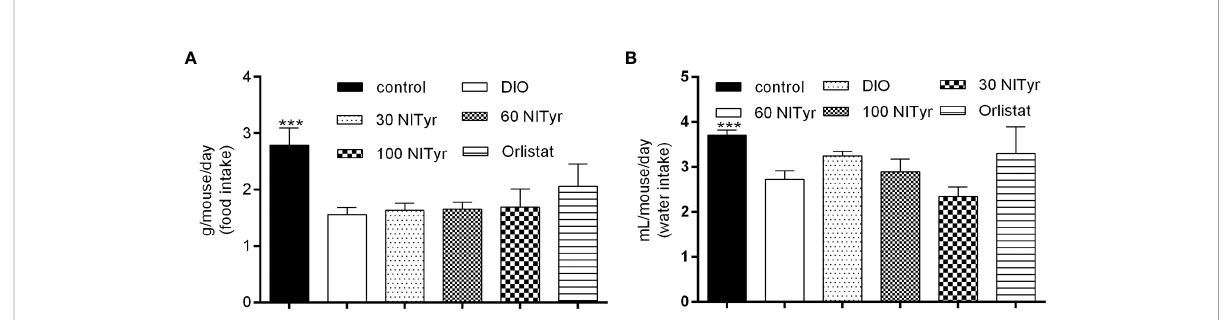
FIGURE 3 (A) Average food intake during 4-week drug intervention. (B) Average water intake during 4-week drug intervention. Control or DIO was treated with Poloxamer 188 aqueous solution. 30 NITyr, 60 NITyr, 100 NITyr and Orlistat were intervened with 30 mg/kg NITyr, 60 mg/kg